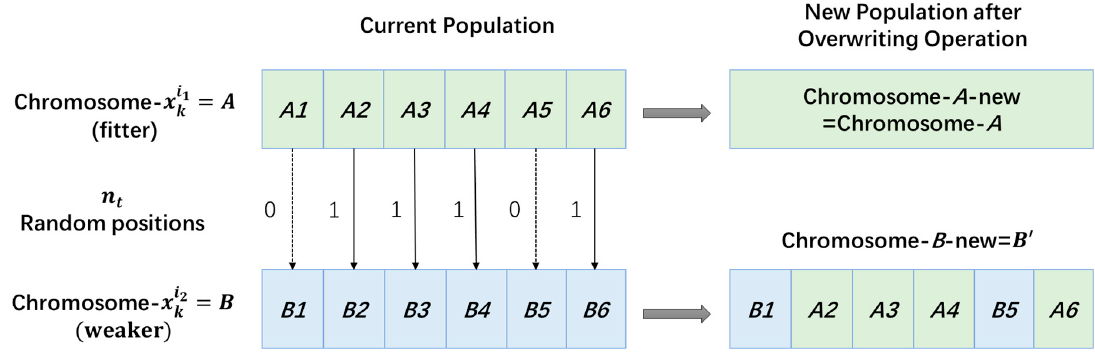
Figure 1. Lamarckian particle filter (LPF) A and LPF B forming offspring B’ via overwriting operation.